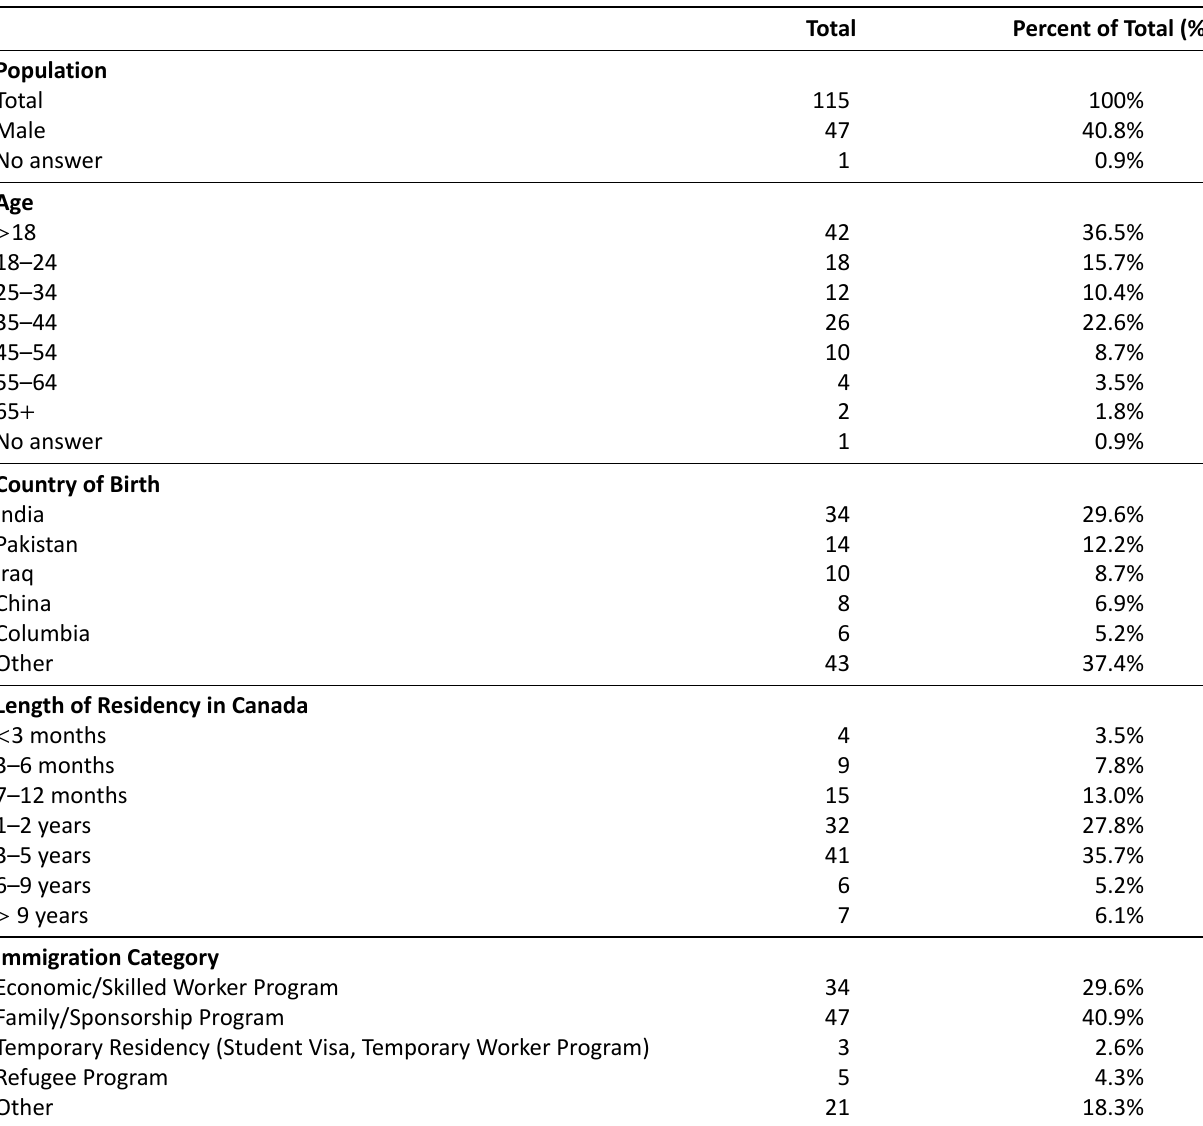
Table 1. Socio-demographic profile of